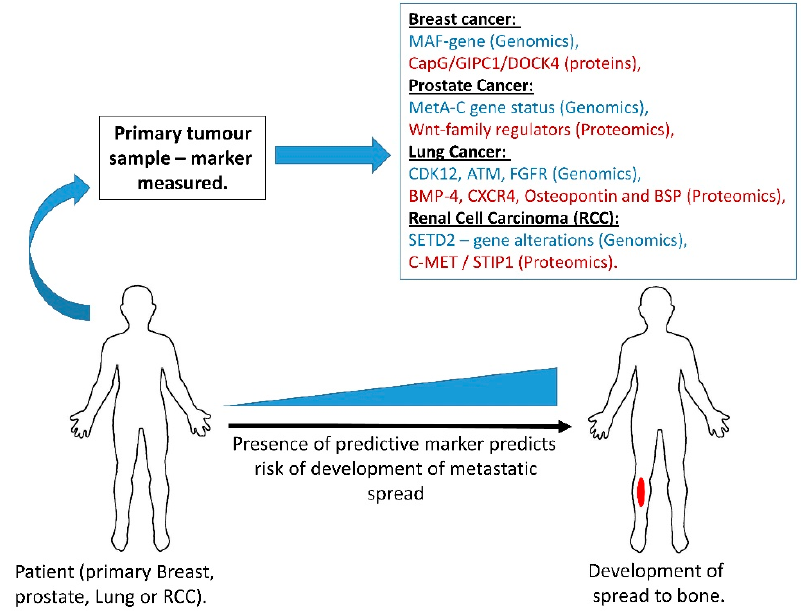
Figure 2. Tissue and potentially circulating biomarkers predictive of risk for cancer spread to bone.